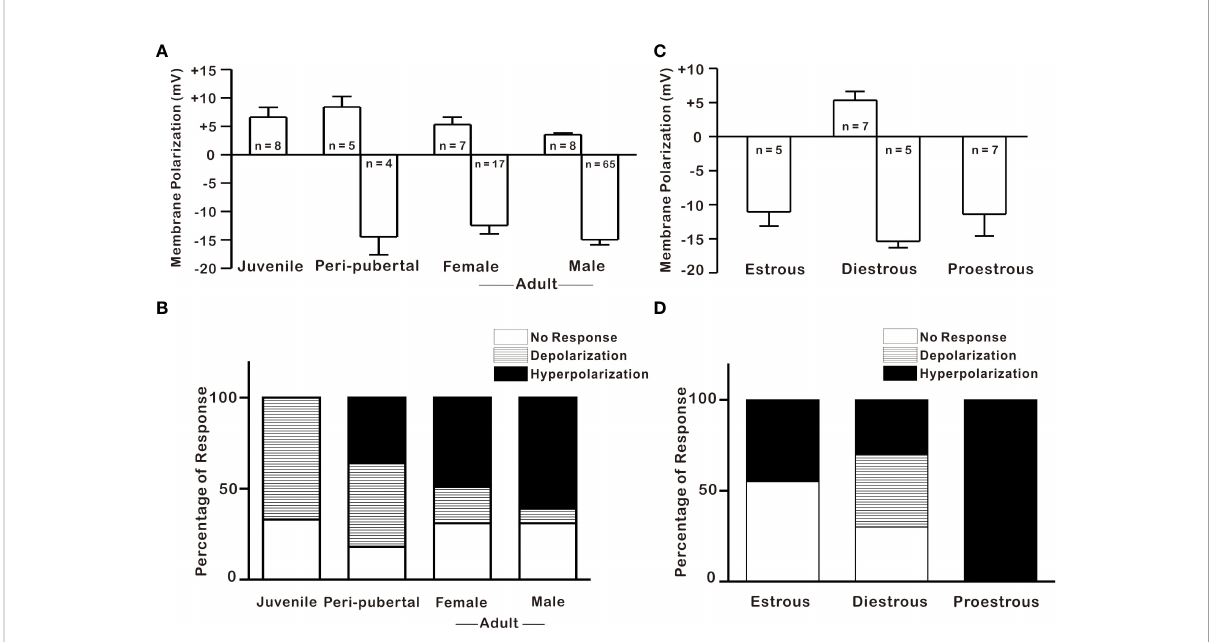
FIGURE 2 H 2 O 2 effect on GnRH neurons across postnatal development and estrous cycle. (A – C) Histograms depicting H 2 O 2 -induced membrane polarization in GnRH neurons throughout the postnatal development and estrous cycle, respectively ( p > 0.05; one-way ANOVA). (B – D) Histograms showing percentages of variegated responses of GnRH neurons by H 2 O 2 exposure across postnatal development and at various estrous cycle stages in adult females,